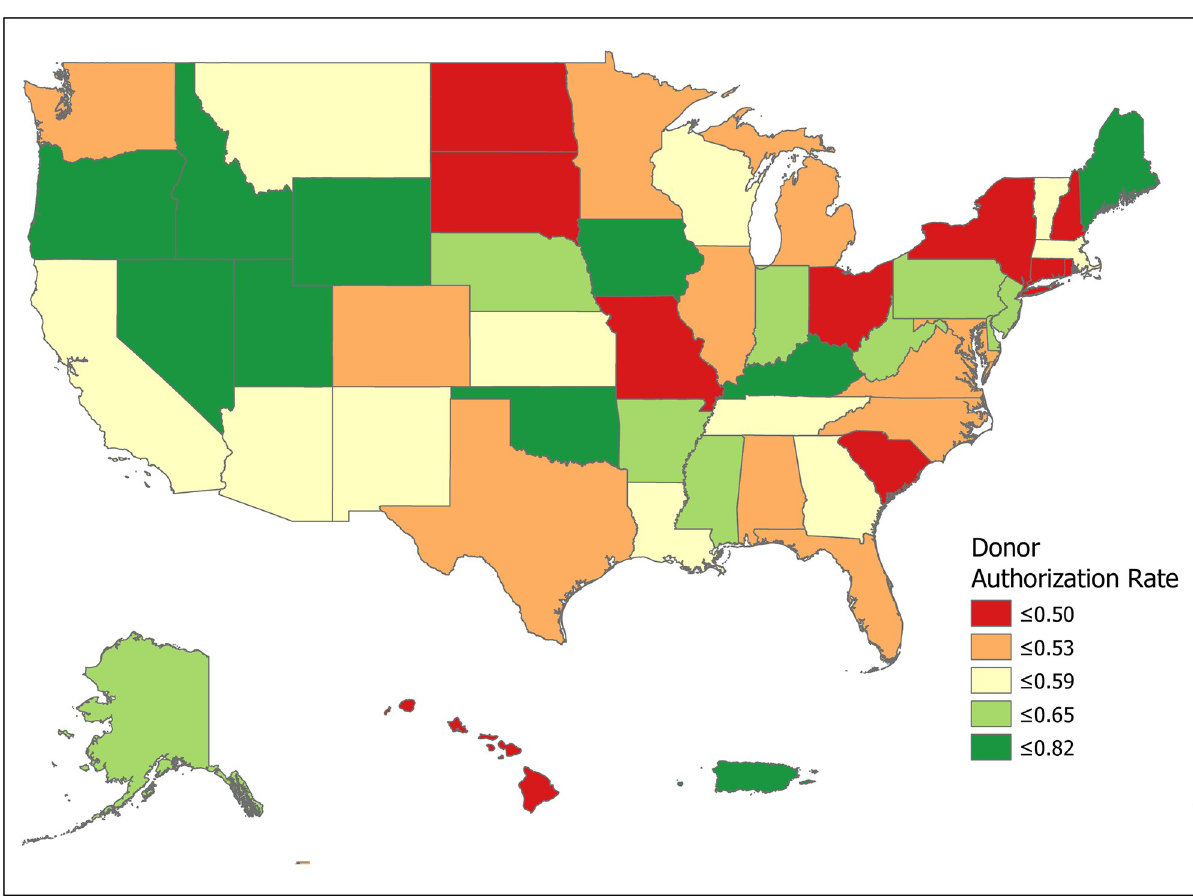
Fig 5. 2018 donor authorization rates, non-registered ( q 2 ). Data come from Tables 1 and 2. Maps created by ArcGIS Pro, URL: https://www.esri. com/en-us/arcgis/products/arcgis-pro/overview. Base Map: World Light Gray Base, URL: https://services.arcgisonline.com/arcgis/rest/services/Canvas.